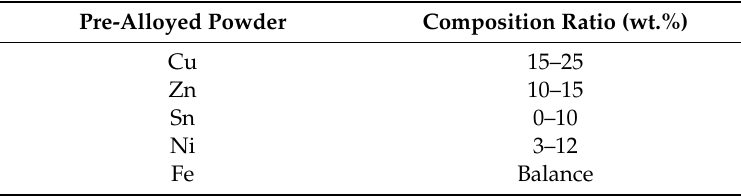
Table 1. Composition ratio of pre-alloyed powder